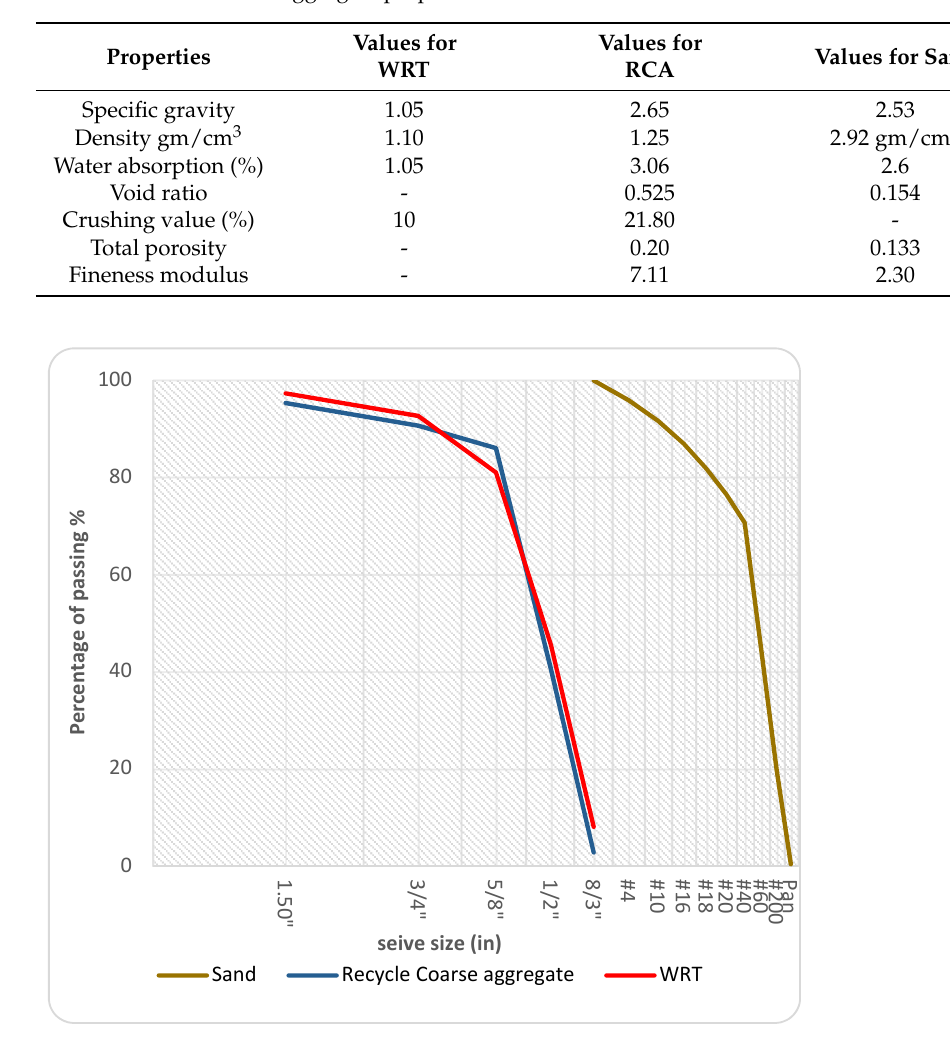
Figure 1. Recycled waste tire and coarse aggregate: ( a ) waste tires; ( b ) rubber particles from the shredding process; ( c ) recycled coarse aggregate. Table 1. Coarse and fine aggregate properties.